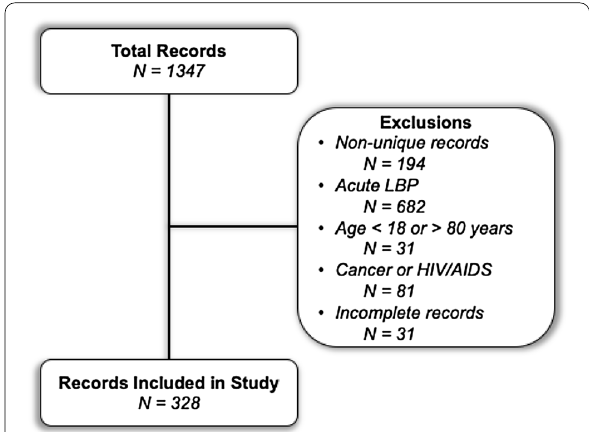
Fig. 1 Flow chart of identifying records